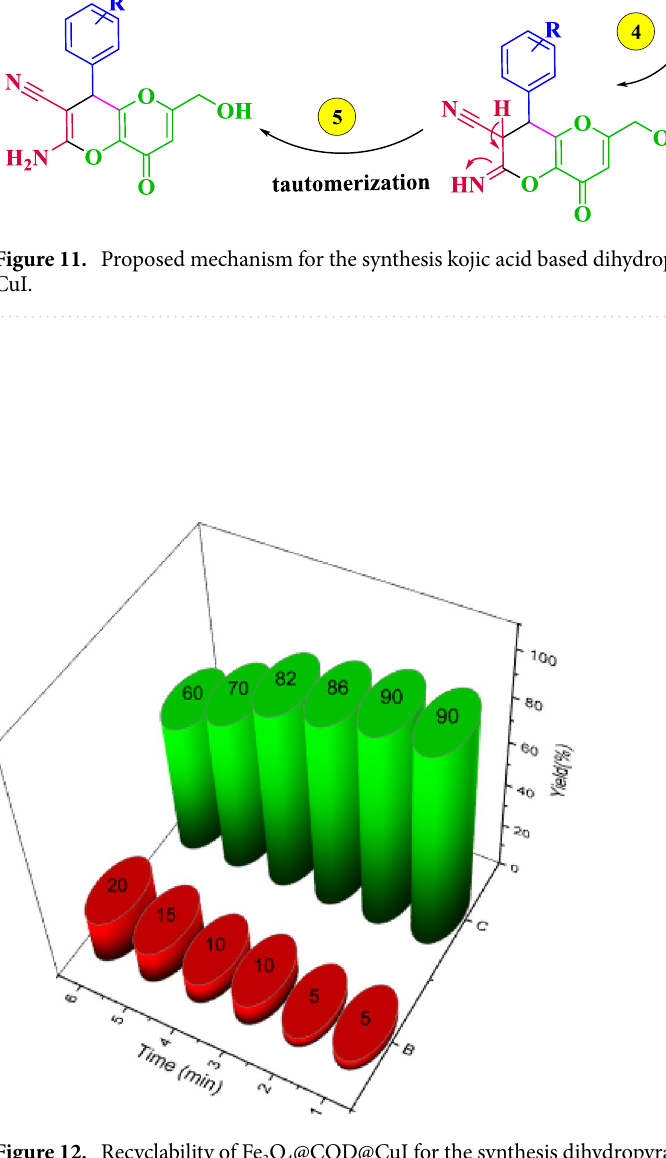
Figure 12. Recyclability of Fe 3 O 4 @CQD@CuI for the synthesis dihydropyrano-pyran